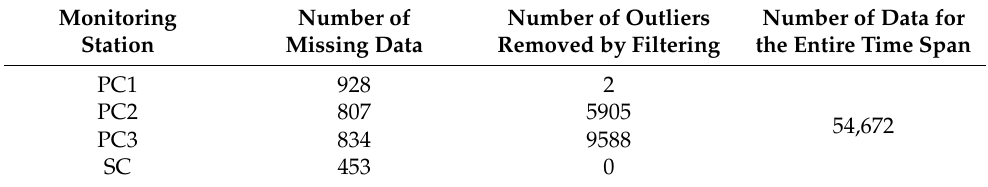
Table 1. Summary of the data collected from the HydroStations.